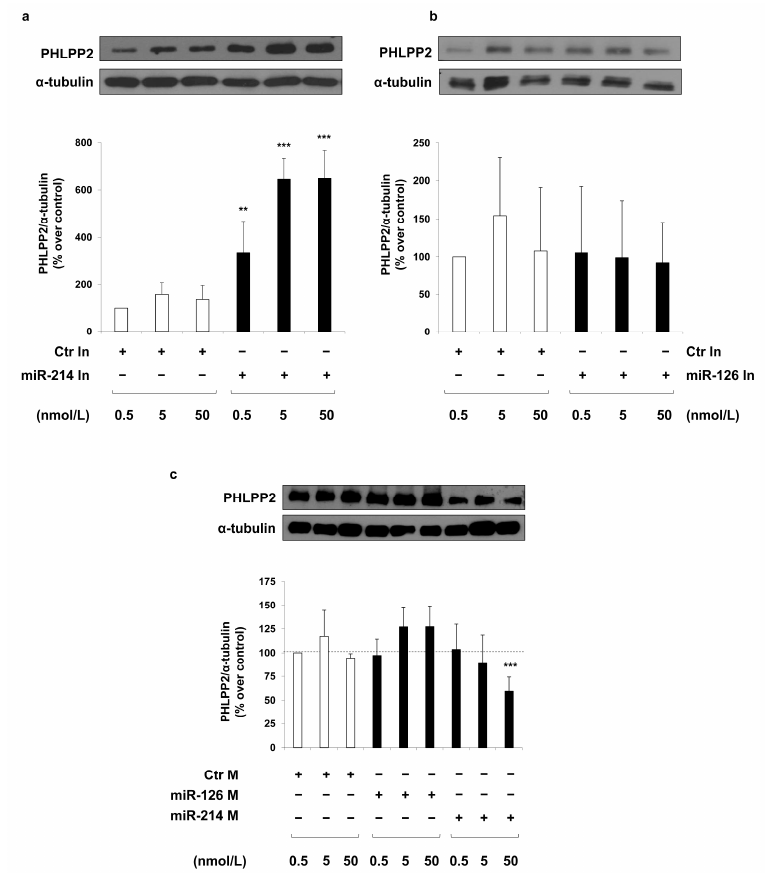
Figure 2. Effect of miR-214 and miR-126 modulation on PHLPP2 protein levels in MAECs. MAECs were transfected with different concentrations (0.5, 5, and 50 nmol/L) of miR-214 ( a ) and miR-126 ( b ) inhibitor (miR-214 In and miR-126 In), or miR-214 and miR-126 mimic (miR-214 M and miR-126 M) ( c ). Transfection with a non-targeting antisense inhibitor (Ctr In; ( a , b )), and a non-targeting control oligonucleotide (Ctr M; ( c )) were used as negative controls. Forty-eight hours after transfection, cells were collected and protein lysates were analyzed by Western blot with anti-PHLPP2 and anti- α -tubulin antibodies. Exposure timing was 4 min for blots in panels ( a ), 2 min for blots in panels ( b ) and 20 min for blots in panel ( c ). Protein levels were quantified by the densitometric analysis of at least three independent experiments. Bars in the graphs represent the mean ± SD of the percent (%) over control (Ctr In or Ctr M) 0.5 nmol/L. Statistical analysis was evaluated using Student’s t -test; ** p ≤ 0.01; *** p ≤ 0.001.